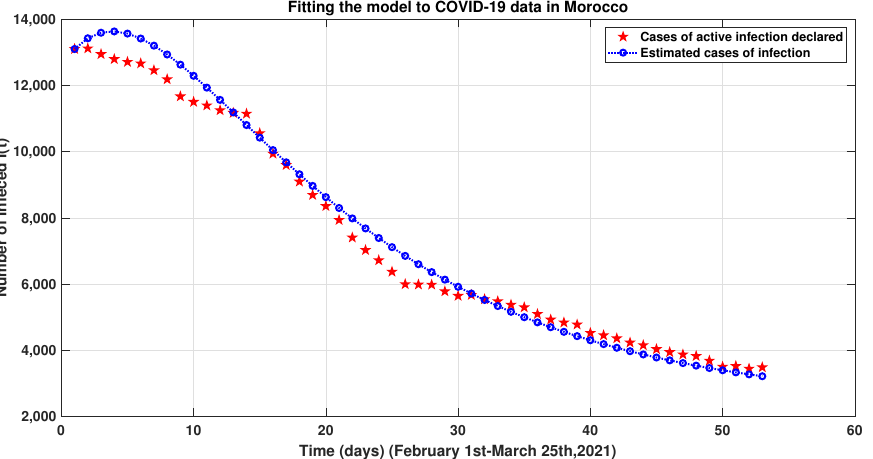
Figure 2. Fitting the infected population with real data from 1 February 2021 to 25 March